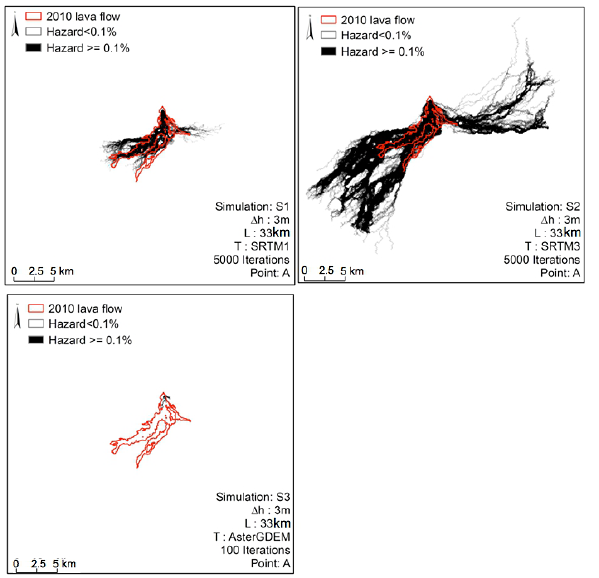
Figure 8. Probability of lava flows invasion from A (emission point of the 2010 eruption of Nyamulagira) for different DEMs (S1, S2, and S3).